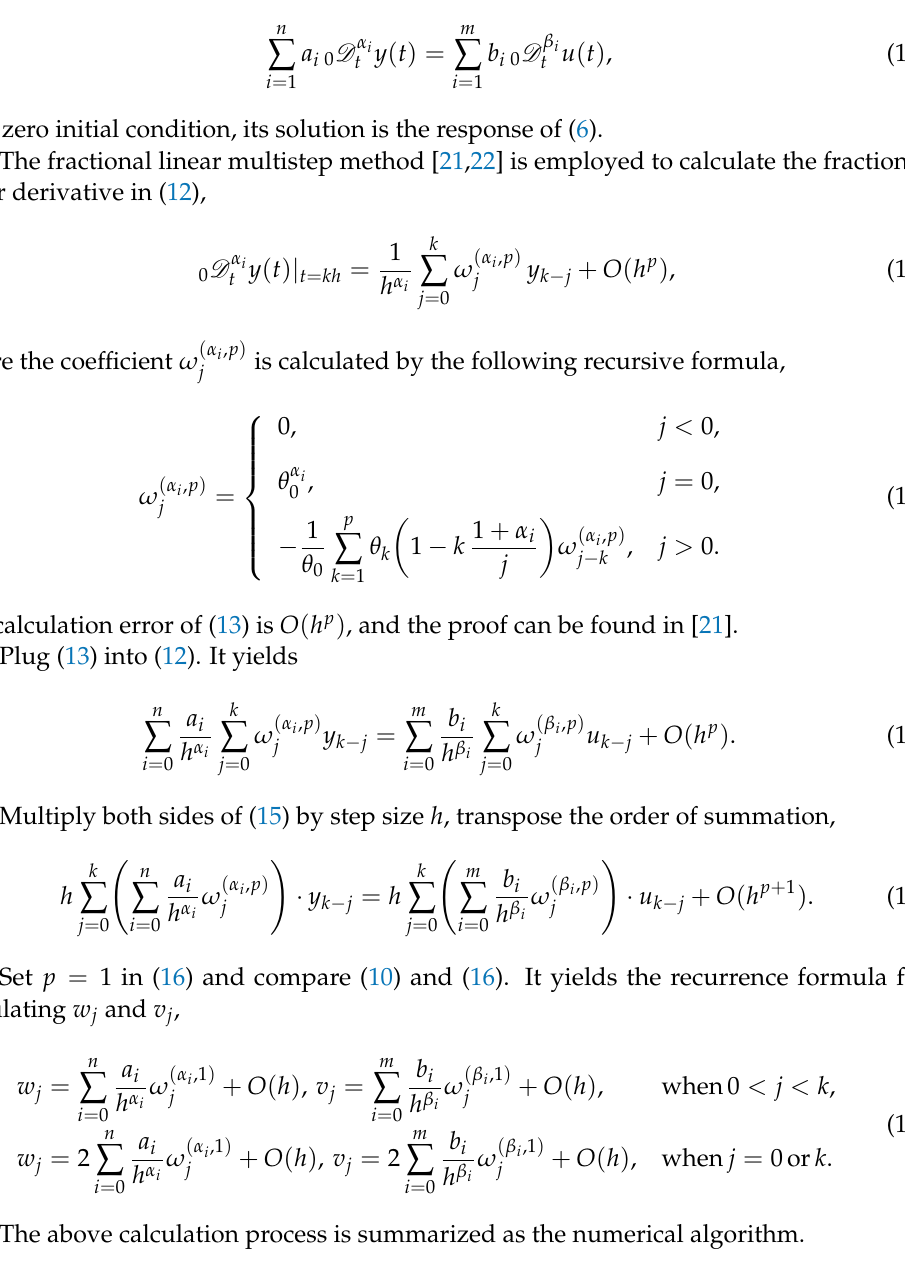
Algorithm 1. Calculating the time domain response of EFOTF (6)